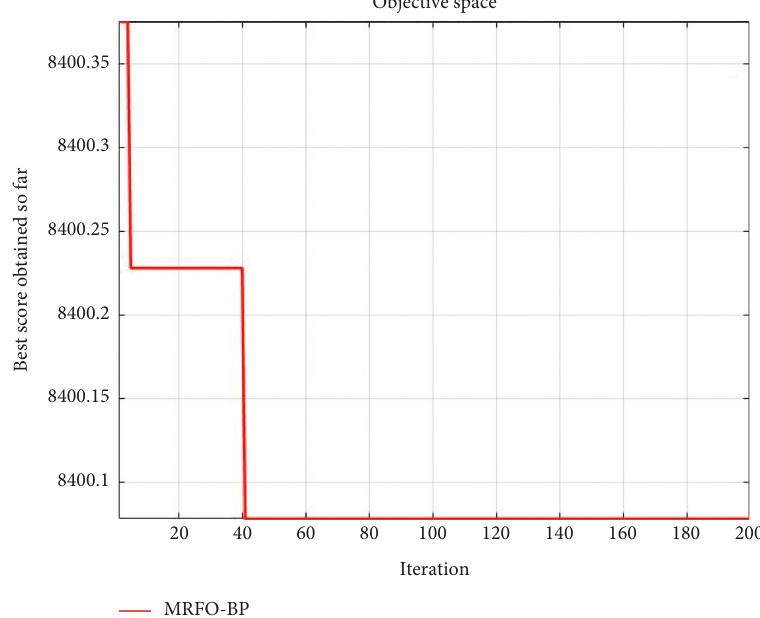
Figure 22: Historical optimal position curve of the tail of the spiral casing (comparative experiment).